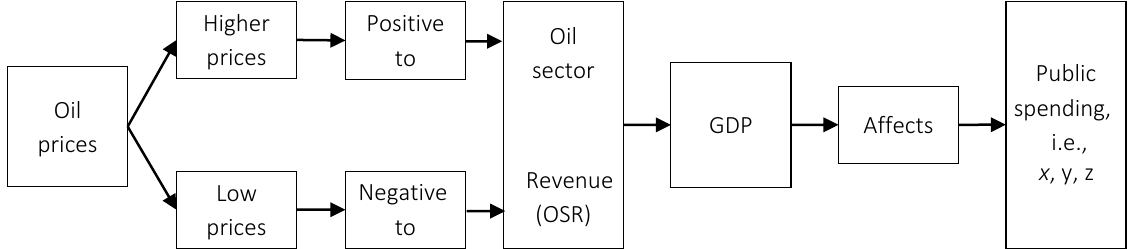
Figure 1. Process of governance of public spending by the oil